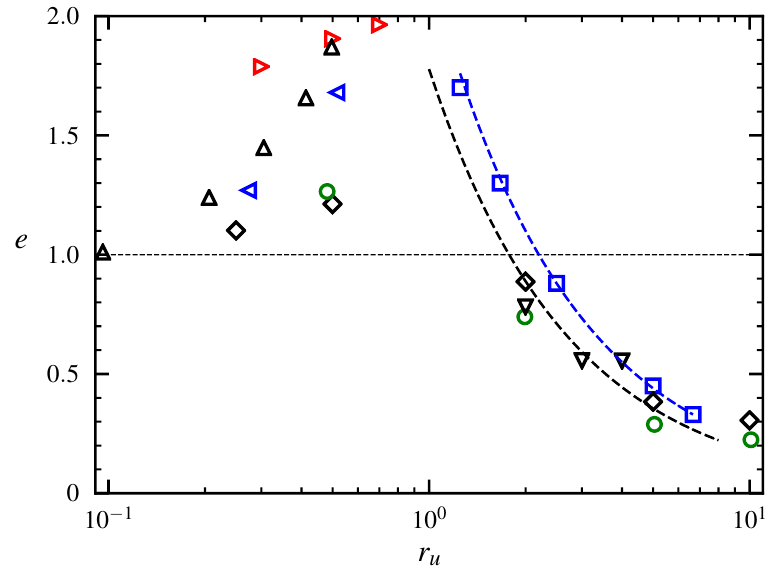
Figure 3. Variation of the ratio between the inner potential core length with external flow to that without external flow, e , versus r u . Replotted based on Au and Ko [27]. ( ) [27], ( ) 2.2/ r u fit r u ( A = 9.9) of [27] for 1.25 6.66, ( ) [36], ( ) [37], ( ) [23], A r = 2.94, ( ) [23], A r = 1.28, ( ) [38], ≤ ≤ r u ( ) [16] ( ) 1.78/ r u fit ( A = 8) of [16] for 1 8. The potential inner core length for a simple ≤ ≤